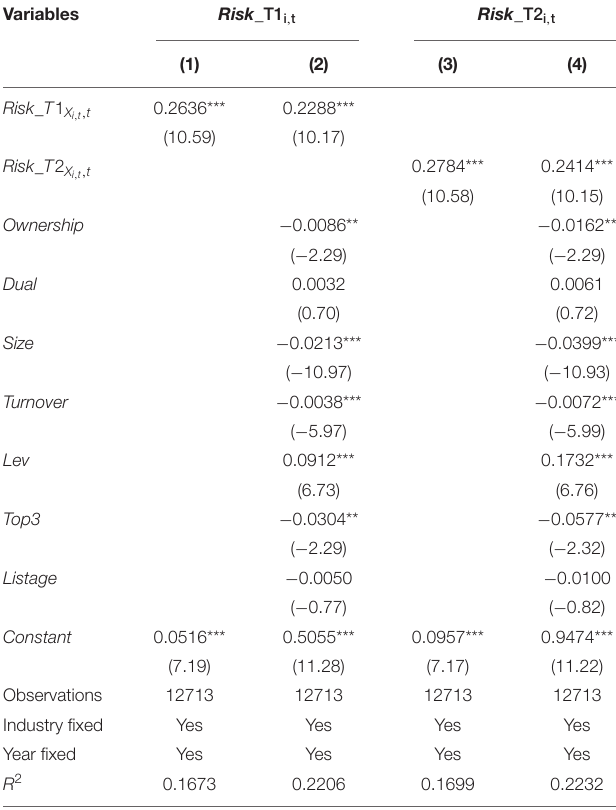
TABLE 5 | Risk-taking of peer firms and corporate